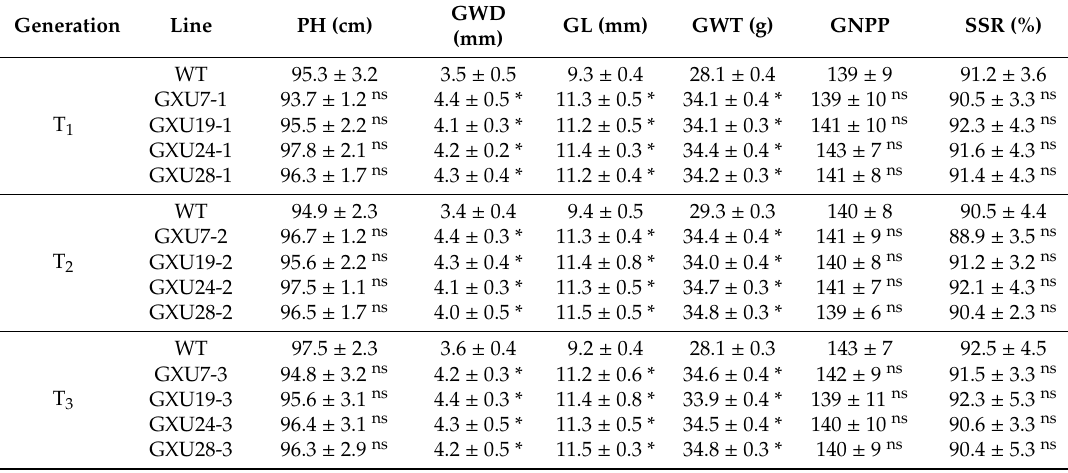
Table 2. Performance of wild-type and homozygous mutant plants for main agronomic traits in T 1 , T 2 , and T 3